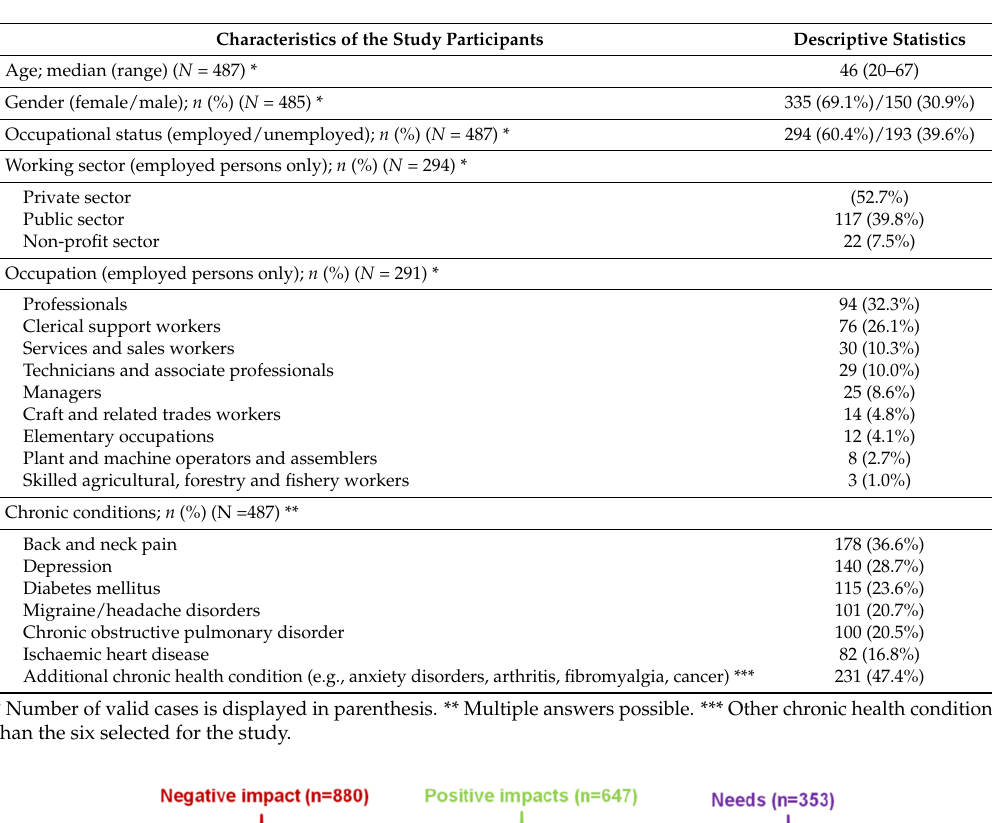
Table 2. Characteristics of the study participants ( N = 487).